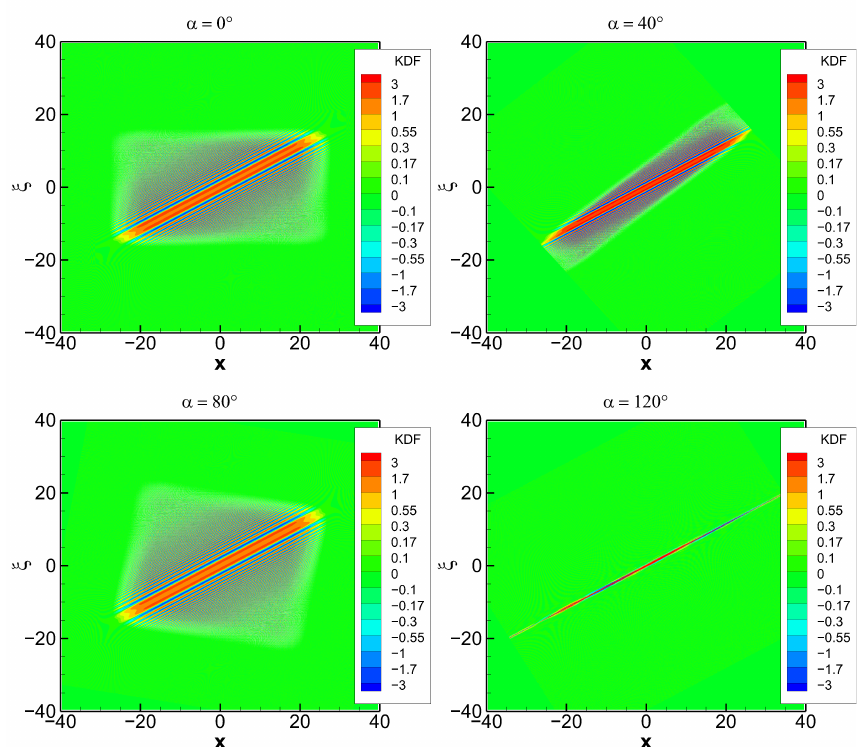
Figure 3. KDF ρ K α of function ˜ ψ α ( y ) interpolated to the unrotated coordinates ( x , ξ ) . The rotation angle α takes the values of 0 ◦ , 40 ◦ , 80 ◦ , and 120 ◦